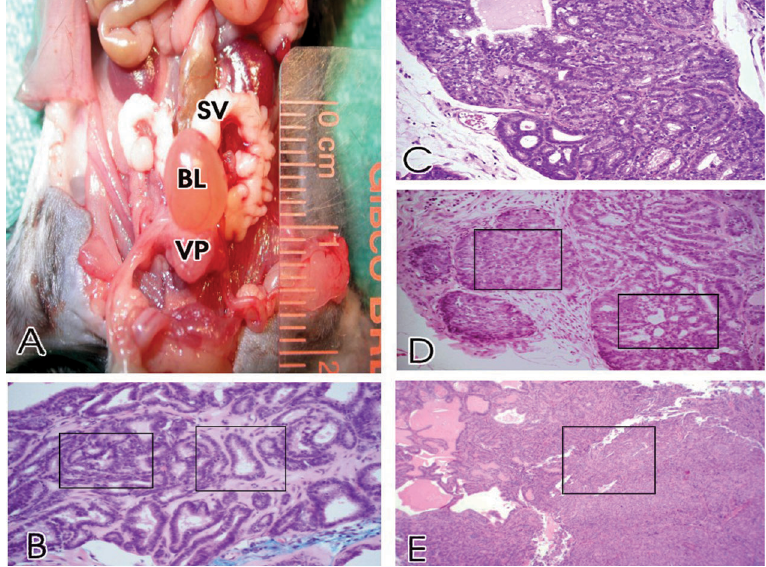
Figure 1. Gross pathology and histological analysis of the knock-in mouse adenocarcinoma prostate (KIMAP) model by a new mouse Gleason analogous grading system. A , Gross pathology of a KIMAP mouse 52 weeks of age after prolonged prostate cancer development showing a 0.3-g ventral prostate lobe tumor. B , Histological score 5 from a KIMAP mouse at age 30 weeks. Two boxes show histological grade 2 (right) and 3 (left) tumor foci. 25X. C , Histological score 6 (histological grades 3 + 3) for a KIMAP mouse at age 30 weeks. 25X. D , Histological score 7 (3 + 4) for a KIMAP mouse at age 45 weeks. Right area , grade 3, small acinar infiltrating the stroma. Left area , grade 4 showing cribriform acini. 10X. E , Histological score 9 (4 + 5) for a KIMAP mouse at age 67 weeks. Boxed area , grade 5. Left area , grade 4. 10X. All sections were stained with hematoxylin and eosin. SV = seminal vesicle; BL = bladder; VP = ventral prostate lobe